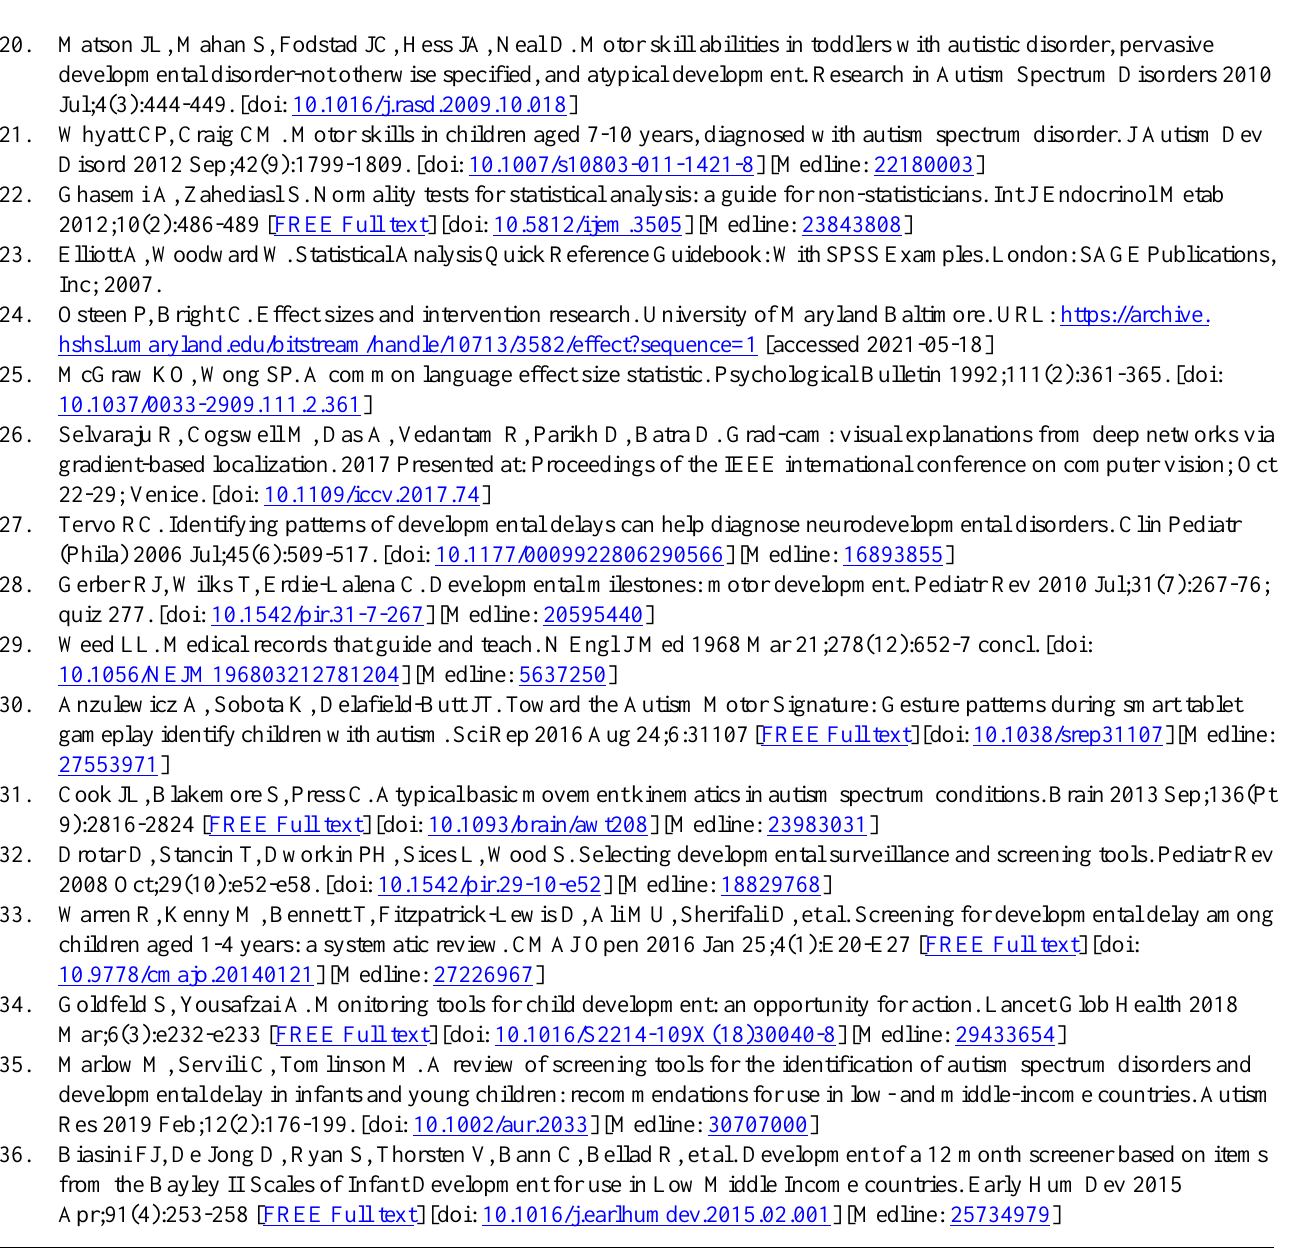
Abbreviations AUROC: area under the receiver operating characteristics curve BRIEF-II: Behavior Rating Inventory of Executive Function II CLES: common language effect size DDST-II: Denver Developmental Screening Tests II Grad-CAM: gradient-weighted class activation